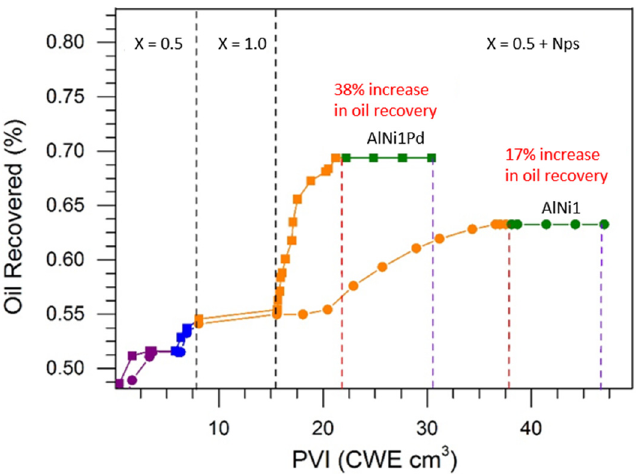
Figure 9. Oil recovery curve profile for steam injection without and with AlNi1 and AlNi1Pd1 nanoparticles at different steam qualities (X = 0.5 and X = 1.0).